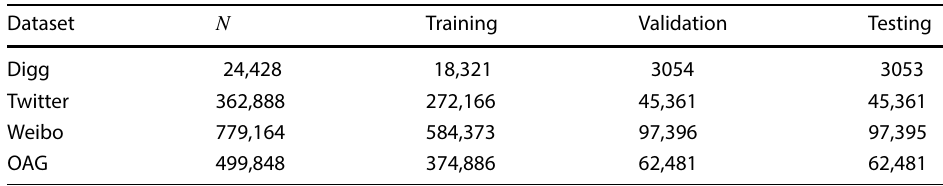
Table 2 The sample partitioning of the training/ validation/testing sets for the four datasets